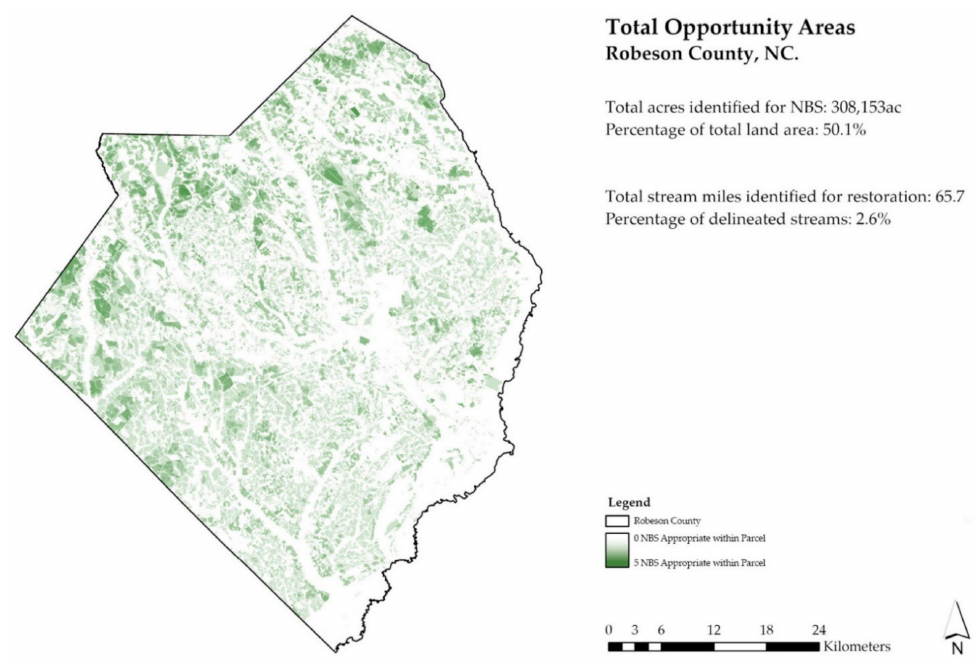
Figure 16. Overlay of all Robeson County parcels with at least one identified opportunity area. Darker values indicate parcels where opportunity areas for multiple FloodWise practices were identified.